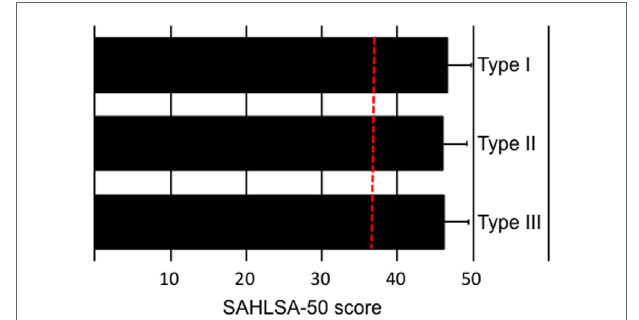
FigUre 2 | Parental health literacy according to hypospadias severity of their child. According to the validated health literacy test for Spanish- speaking adults, SAHLSA-50, there is no difference in health literacy among parents according to severity of their child. The dotted red line demarcates the minimum score that is required for an adequate health literacy level (score of